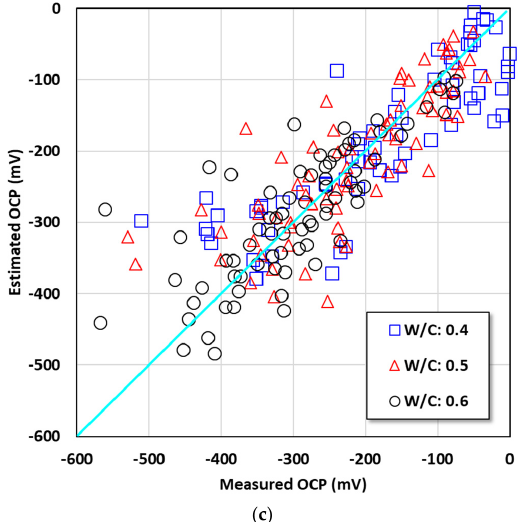
Figure 13 . Regression analysis of the corrosion parameters for open-circuit potential (OCP): ( a ) wet condition, ( b ) 3.5% concentration, and ( c ) 7.5% concentration. Table 6. Regression results of the open-circuit potential (OCP) with exposure and cover depth. W / C , water-to-cement.